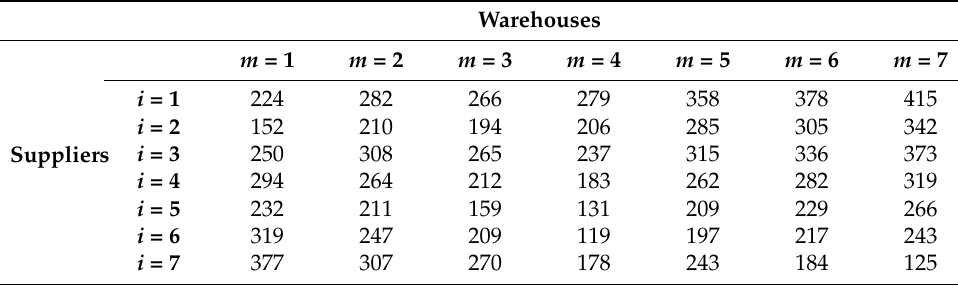
Table A1. Distances between suppliers ( i ) and warehouses ( m ) in